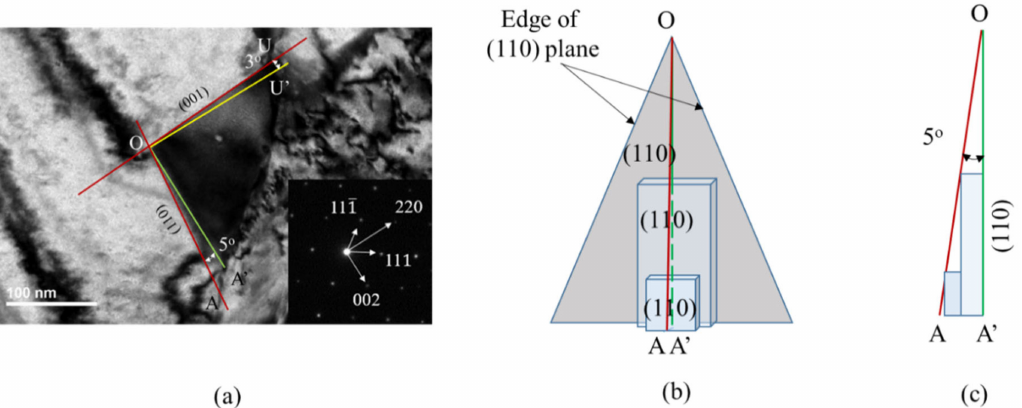
Figure 7. Schematic diagram showing multilayer growth of M 23 C 6 carbide on the (110) plane: ( a ) TEM image and diffraction pattern at the [110] beam direction where yellow and green lines are (001) and (110) planes, respectively, ( b ) three-dimensional view and ( c ) side view of multilayer growth of carbide on the (110)